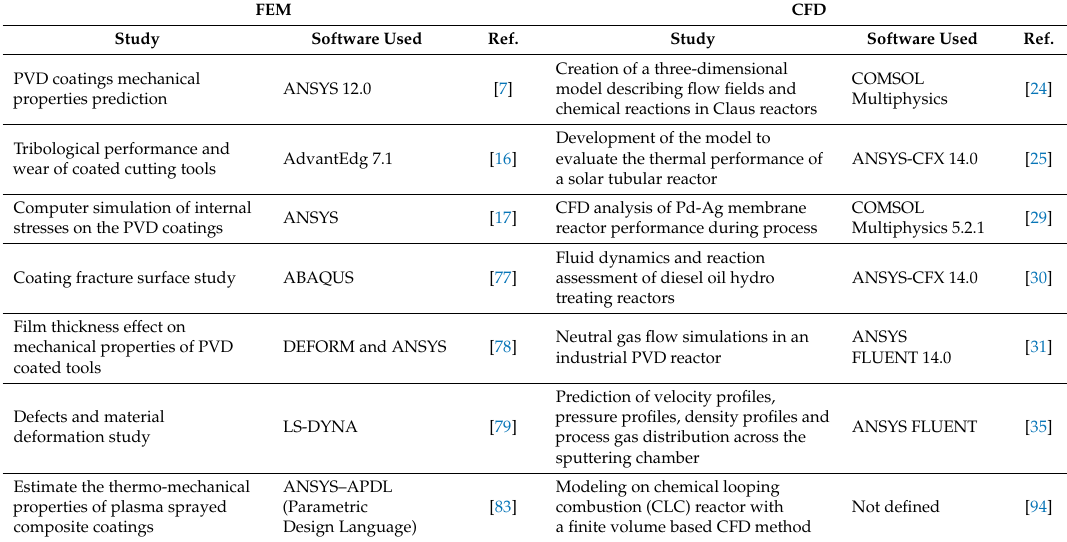
Table 2. Works carried out using FEM and